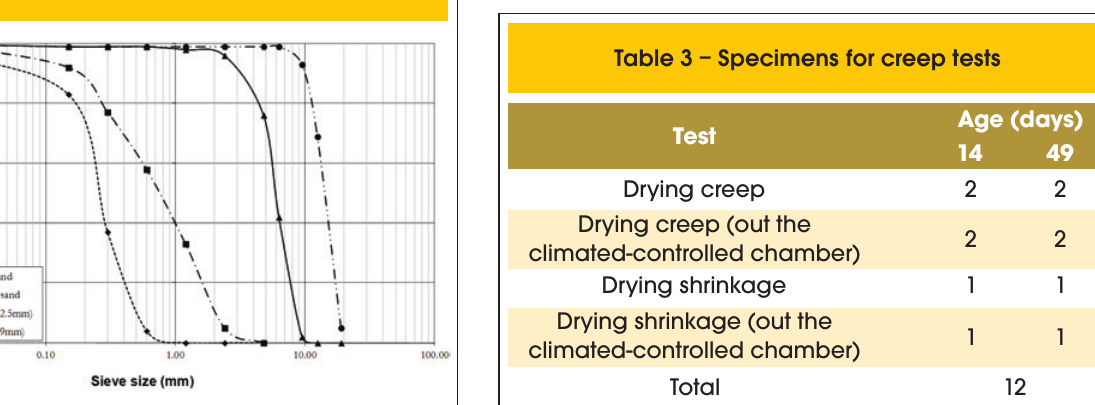
Figure 1 – Aggregates gradation